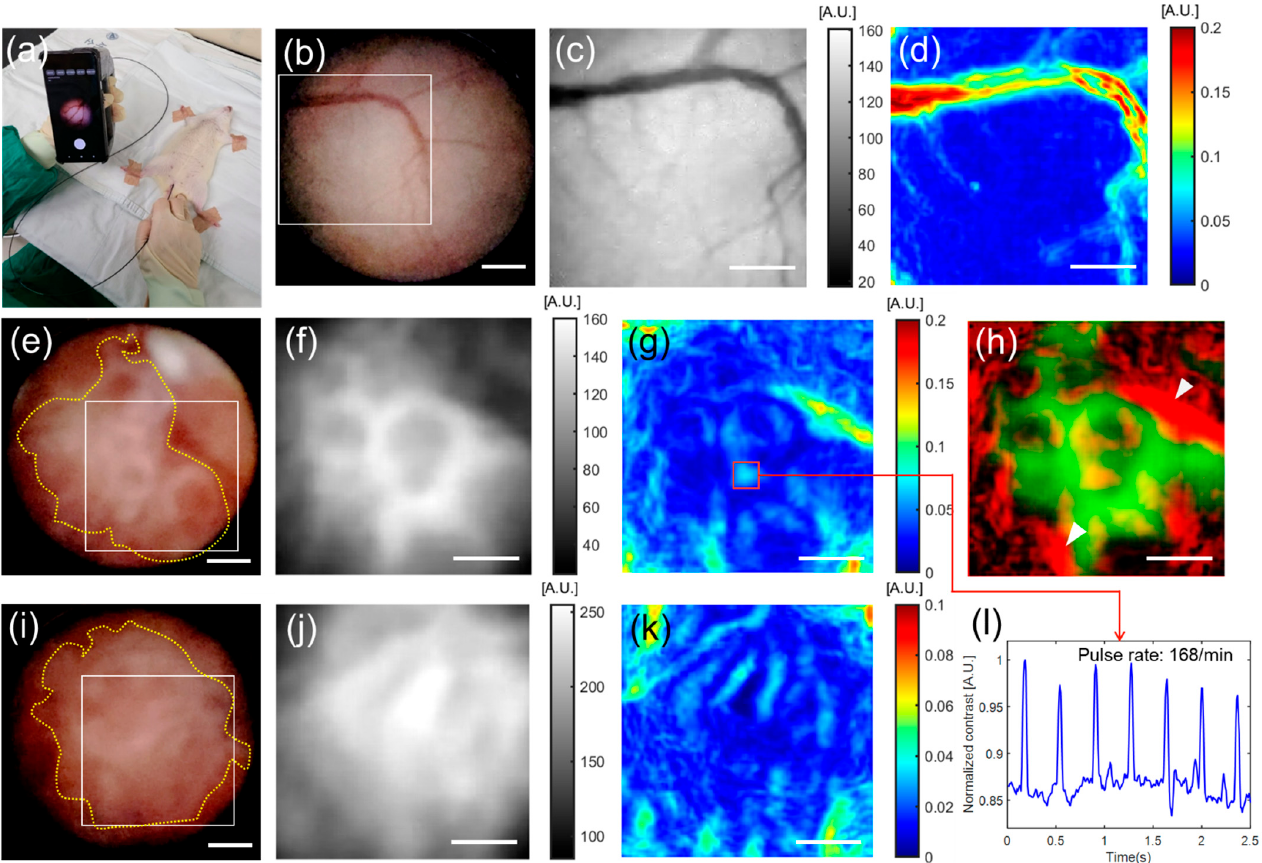
Figure 5. In vivo rat bladder endoscopy using the smartphone-based LSCI endoscope device: ( a ) anesthetized rat under cystoscopy operated by a clinician using the device; ( b ) white light image of the normal rat bladder, showing typically healthy bladder lumen; ( c ) grayscale raw speckle image at a region of interest (ROI) marked as a boxed area in ( b ), and corresponding laser speckle contrast image ( d ), visualizing a major bladder vessel and its branches; ( e , i ) white light images of the bladder cancer rat models, commonly exhibiting a mass of tumors (dotted lines) growing on the bladder wall; ( f , j ) grayscale speckle images of ROIs (boxed areas in ( e , i )); ( g , k ) laser speckle contrast images of ( f ) and ( j ), delineating complex micro-vasculatures in the tumors, morphologically different from the normal vessel ( d ); ( h ) overlaid image of ( f ) (green) and ( g ) (red), depicting the tumor vascularity sprouted from major bladder vessels (arrowheads); ( l ) plot of time-course speckle contrasts recorded at a box in ( g ); the pulsatile contrast change may be due to blood pulsation caused by heartbeats. Scale bars: 1.0 mm.